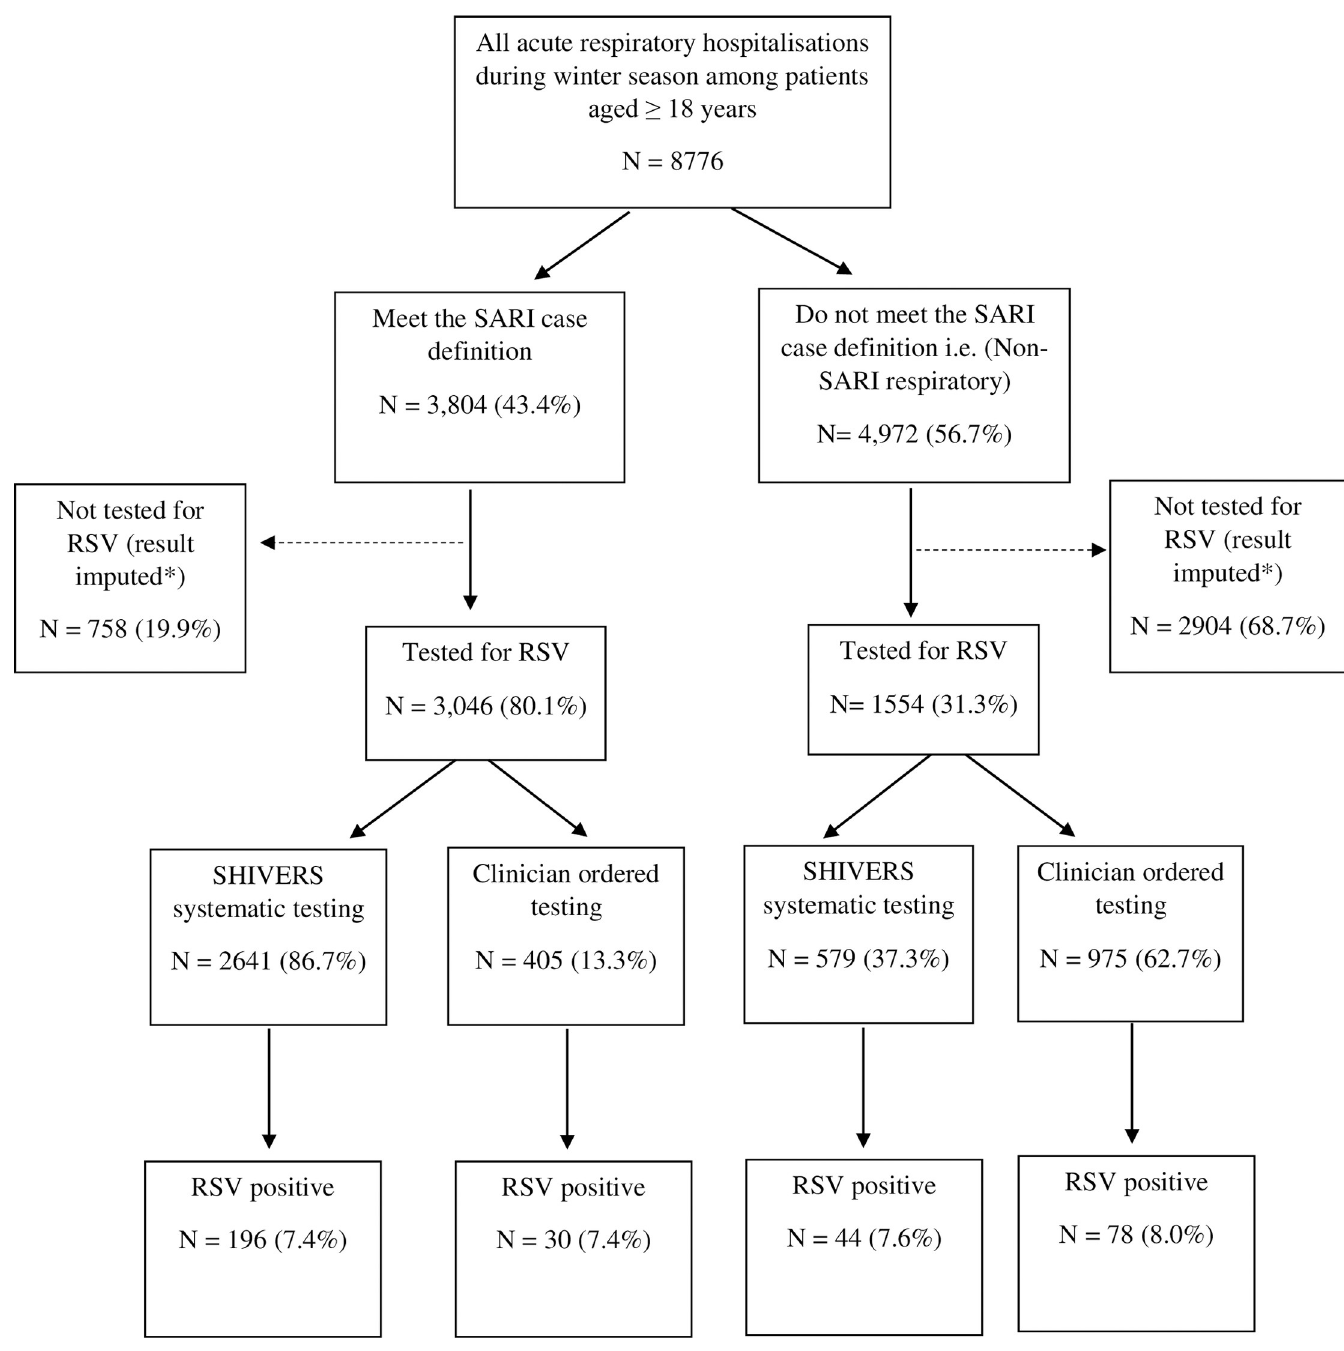
Fig 2. Flowchart detailing retrospective cohort of adults aged � 50 years in Auckland, New Zealand in 2012–2015 and number of acute respiratory infection (ARI) and respiratory syncytial virus (RSV)-tested hospitalizations. � For incidence rate calculations, correction of non-testing among ARI patients was done using two methods; first by multiplying the proportion positive for RSV in each demographic strata to non-tested ARI patients in each group; and second by using the multivariate imputation by chained equations (MICE) method of imputation in STATA [25].